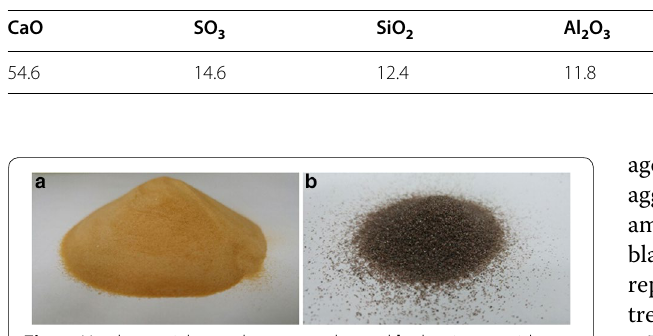
Fig. 5 Used materials: a polymer powder, and b aluminum oxide.